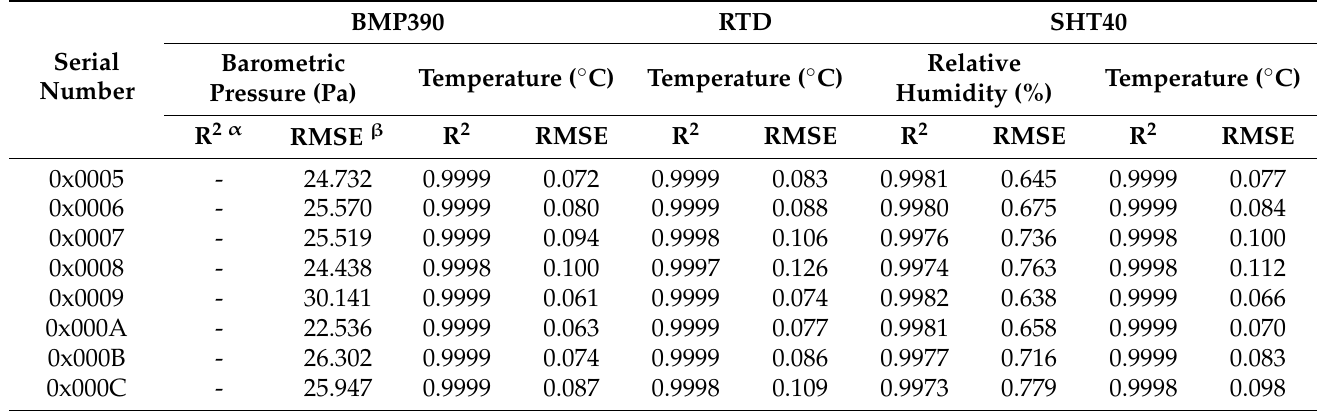
Table 12. Goodness of fit statistics, coefficient of determination (R 2 ), and root mean square error (RMSE) for validatsion data.